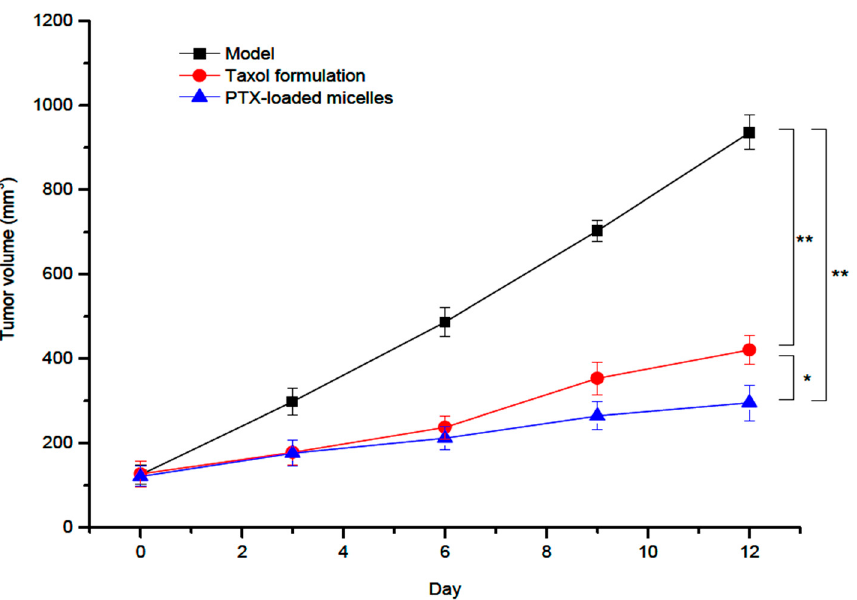
Figure 7. In vivo antitumor activity of Paclitaxel (PTX)-loaded mPEG-CS(SH)-CHO micelles: tumor volume growth curves after various treatments (* p < 0.05; ** p < 0.01) [55].